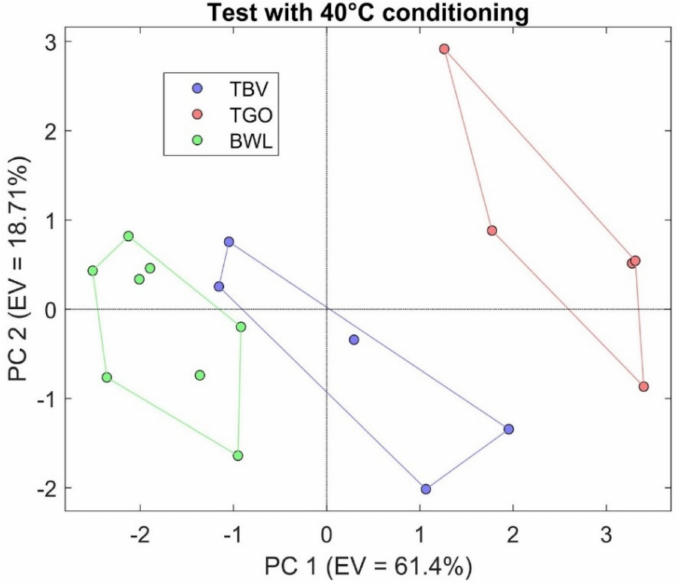
Figure 1. PCA analysis representing the results obtained from the comparison between black, green, and white tea.